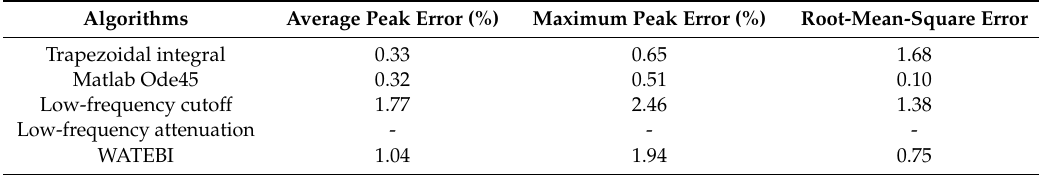
Table 5. Five methods for the velocity reconstruction of Kaikoura event.